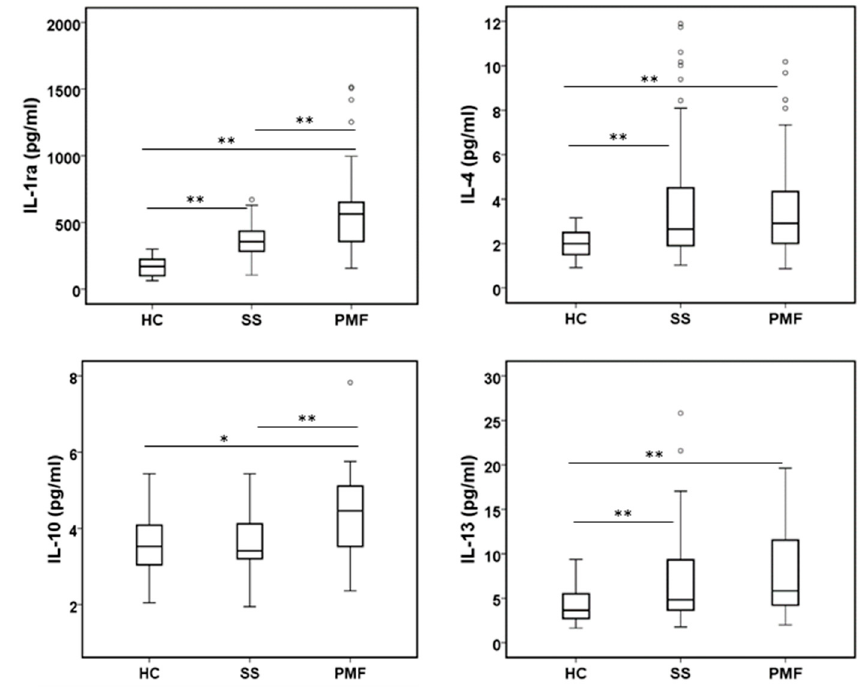
Figure 2. Levels of anti-inflammatory cytokines in plasma from peripheral blood were assayed in all participants. All cytokines were assayed by the Bio-Plex assay. * and ** indicate significance p < 0.05 and p < 0.01, respectively.